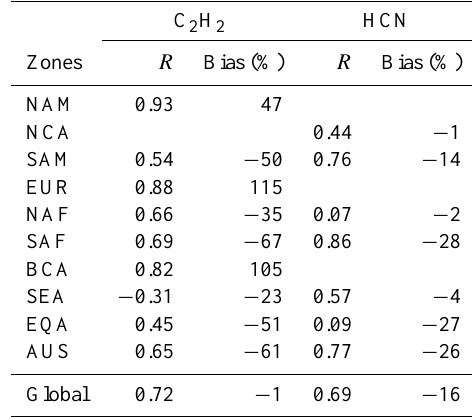
Table 3. Correlation coefficients ( R ) and biases (Bias) between IASI observations and MOZART-4 simulations for each of the zones defined in Fig.